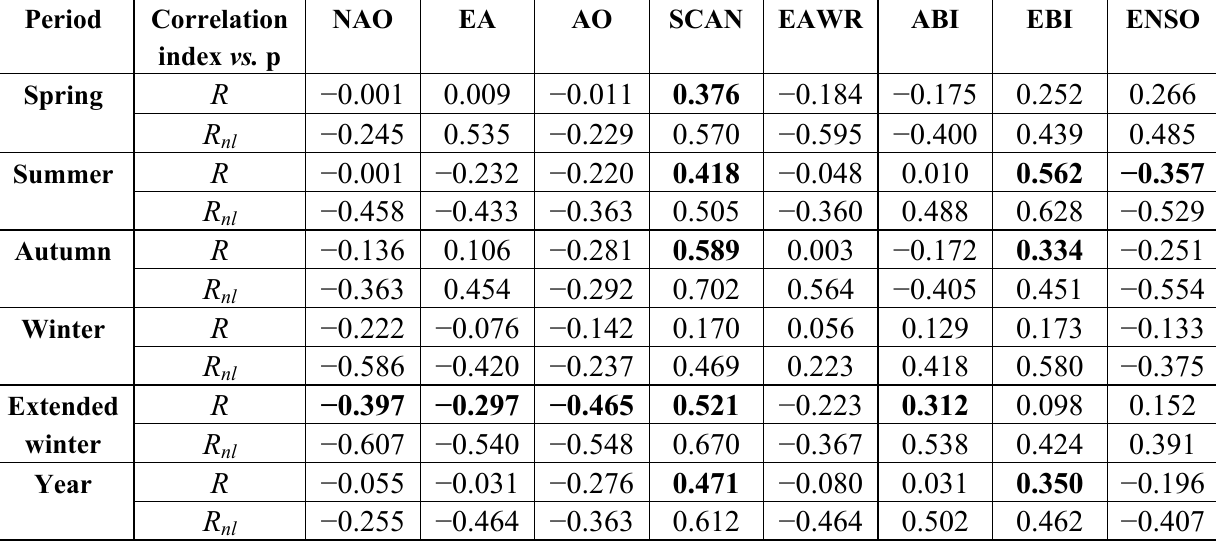
(indices vs. precipitation) for several periods. nl